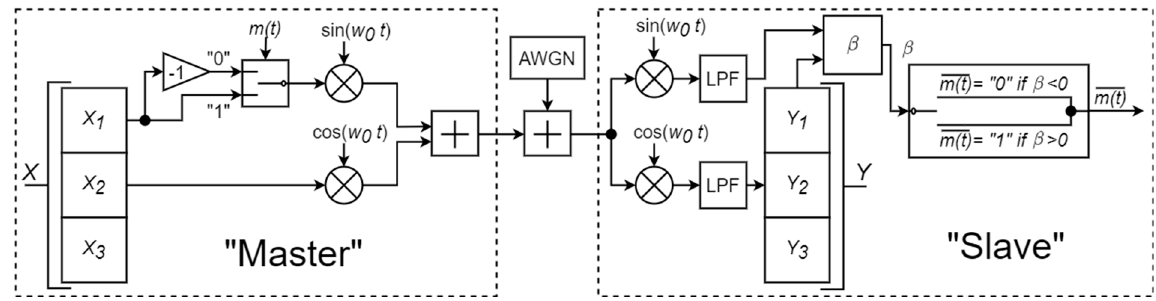
Figure 1. Block diagram of the quadrature chaos phase-shift-based communication system [16].